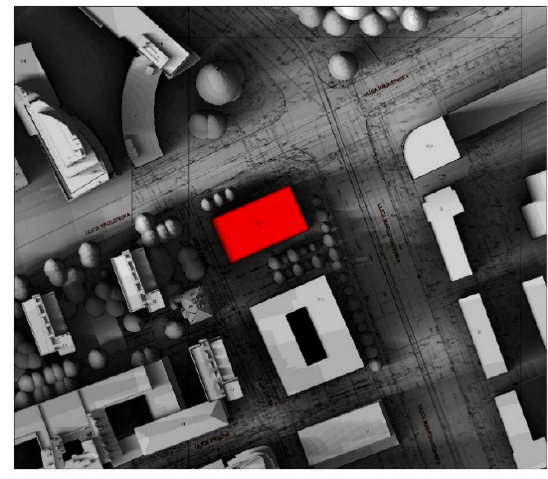
Figure 3. Summer Solstice—Collective shadow analysis for designed building.